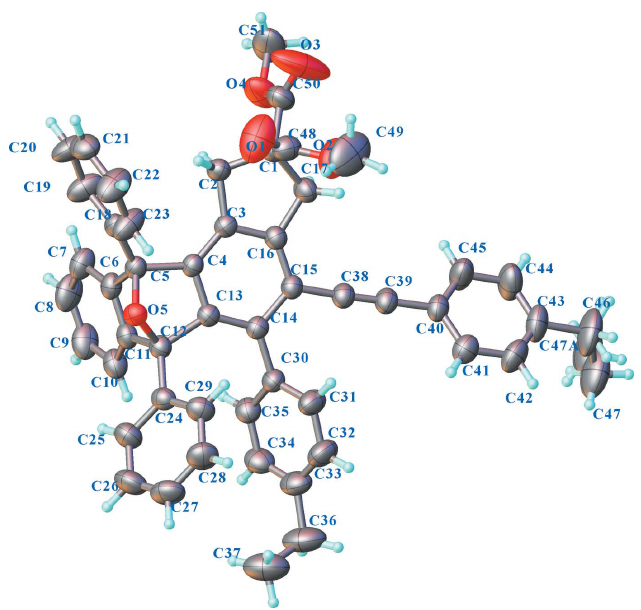
Figure 1 The molecular structure of the title compound, with atom labels and displacement ellipsoids drawn at the 50% probability level. H atoms are shown as small circles of arbitrary